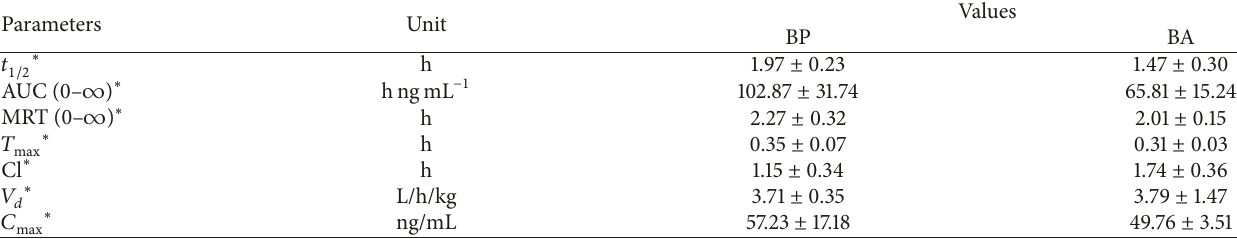
Table 5: Pharmacokinetic parameters of BP and BA in rats after intragastric administration.